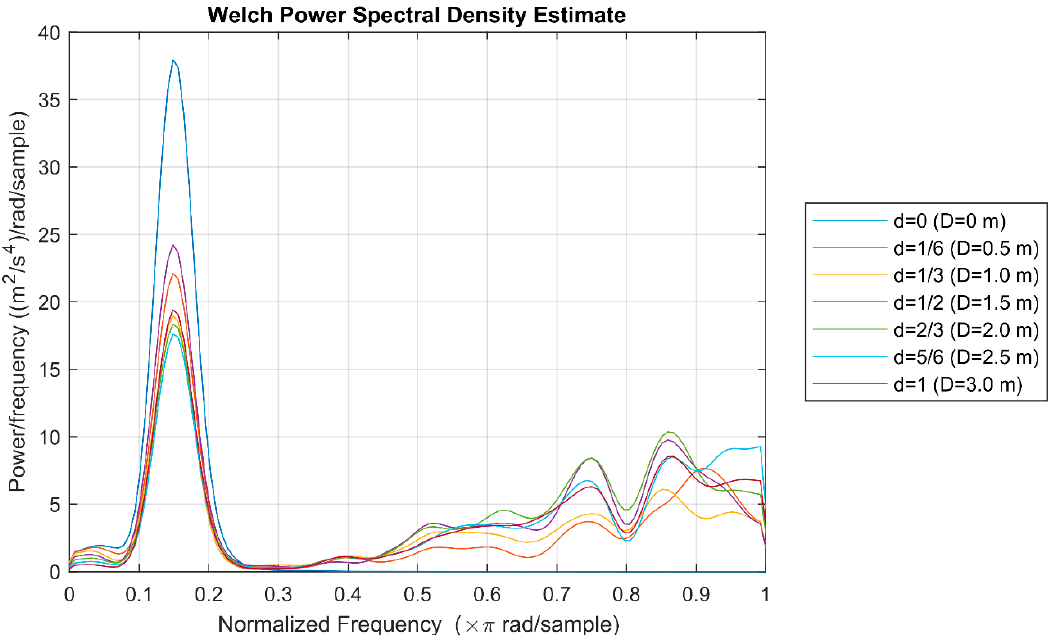
Figure 16. Acceleration spectra of the actuated mass in the second ground profile tested.